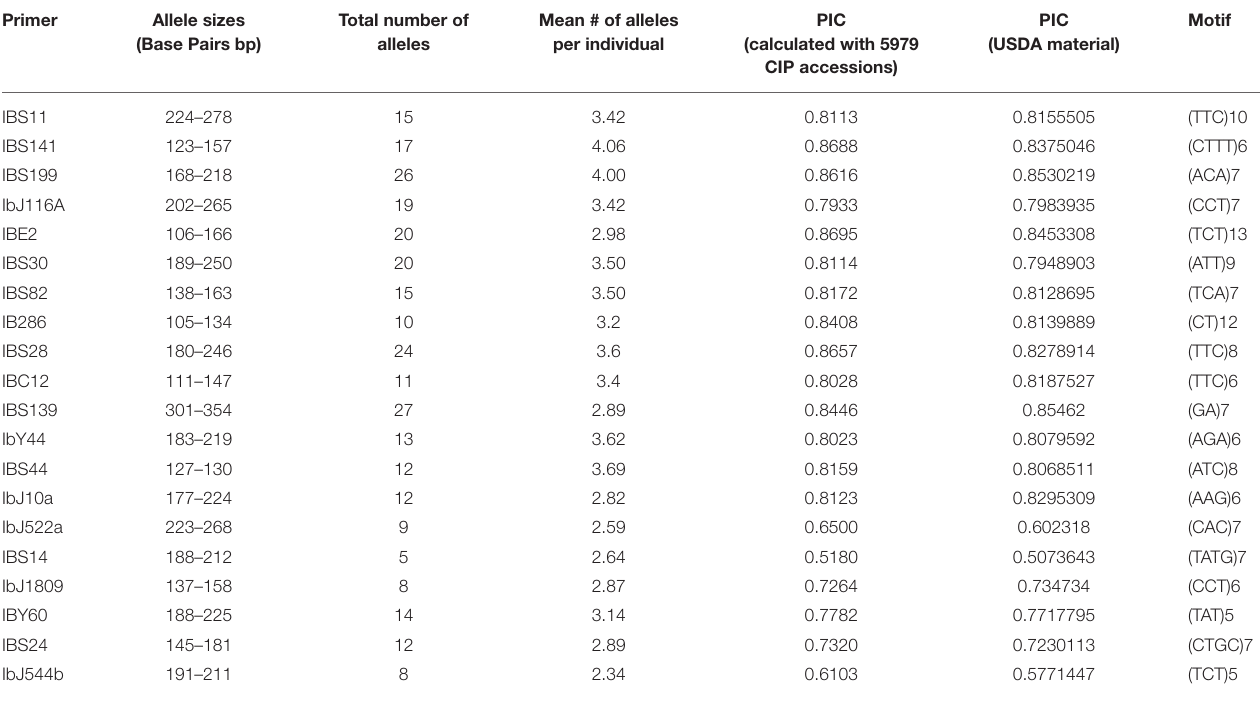
TABLE 2 | Summary of SSR markers utilized in the current study including the total number of alleles, polymorphism information content (PIC) value, motif type, and allele sizes as detected in sweetpotato.